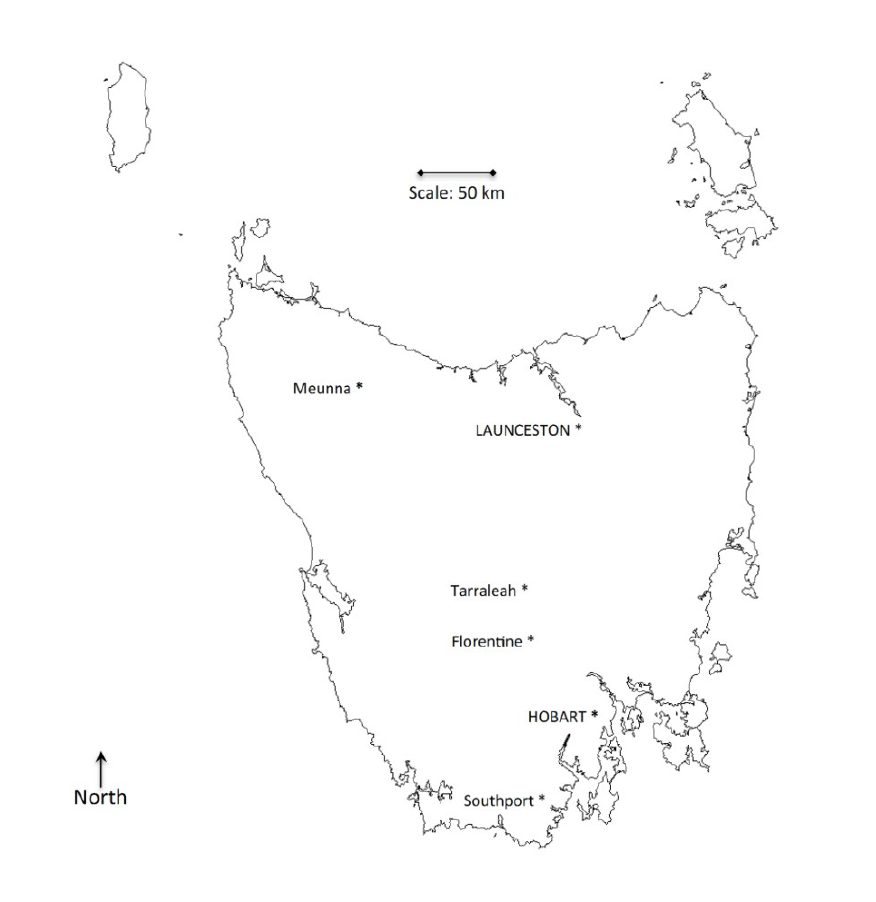
Figure 1. Map of Tasmania showing locations of the four Eucalyptus nitens base population progeny